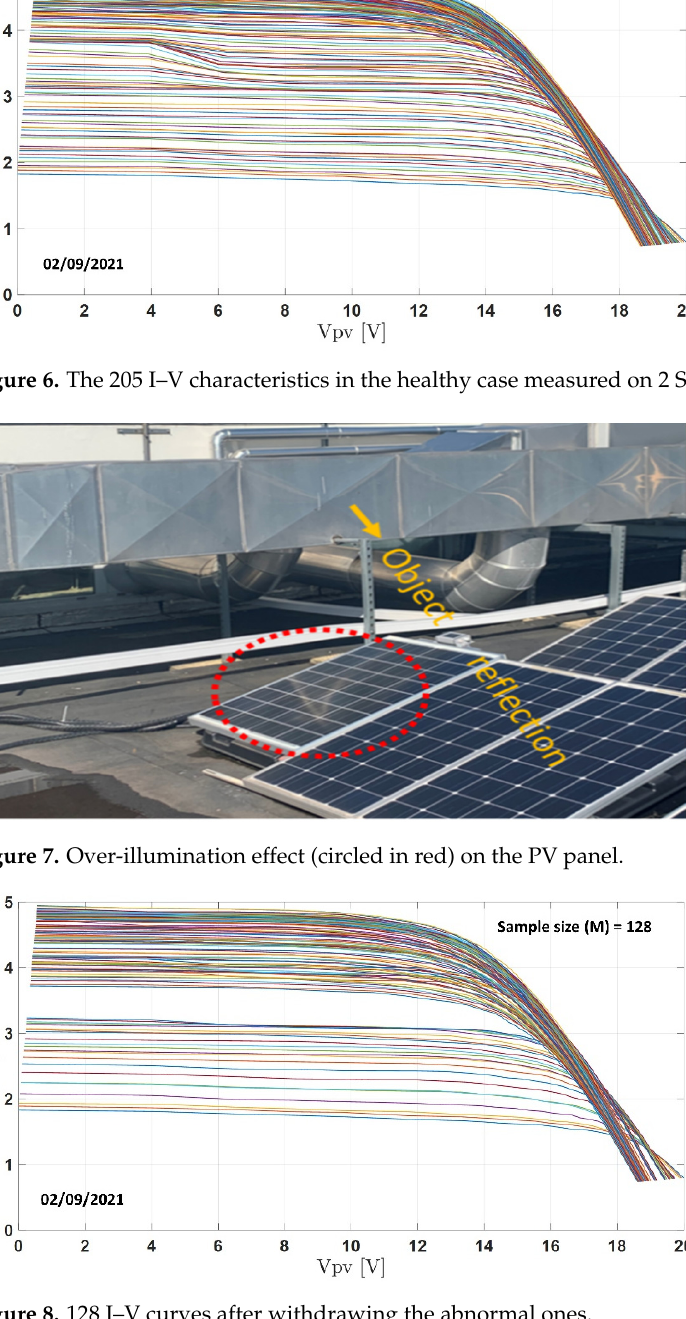
Figure 8. 128 I–V curves after withdrawing the abnormal ones .